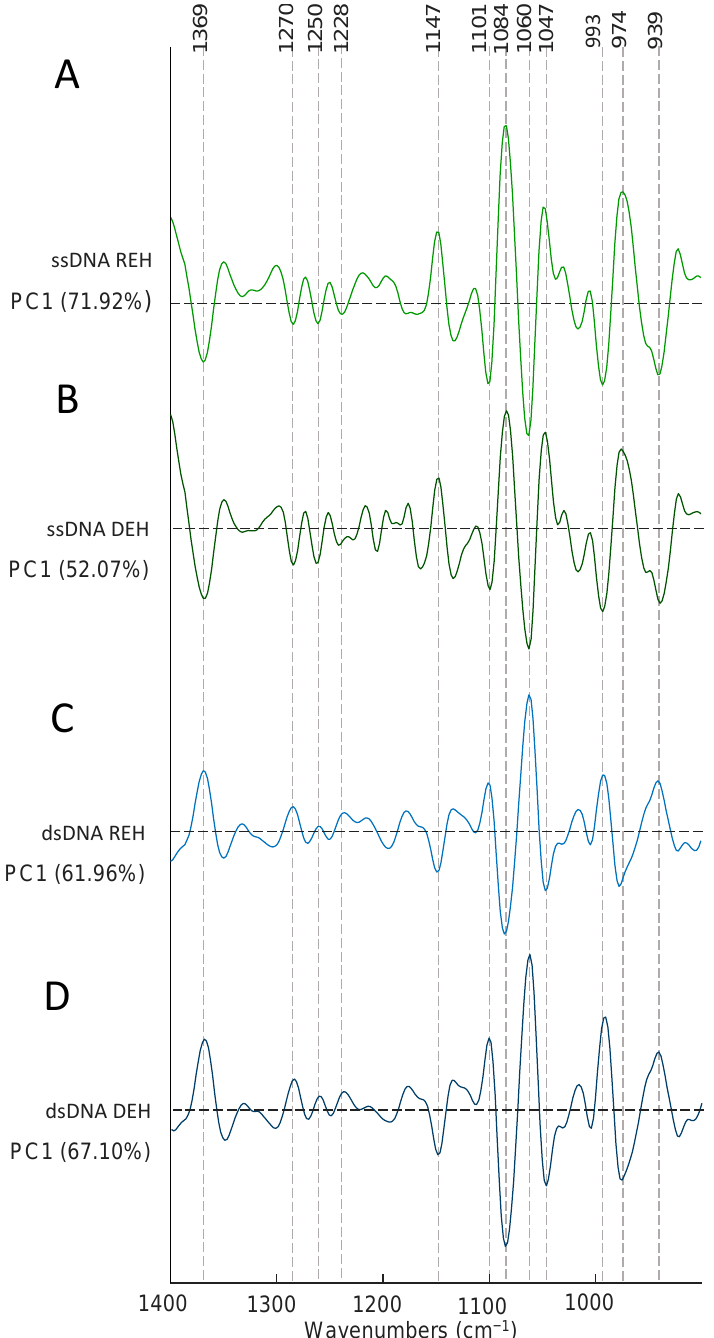
Figure 8. ( A ) PC1 loadings plot depicting ssDNA treated with PFB and TMB and the non-treated DNA (control in acetone/water) in the dehydrated state. The positive loadings are associated with the controls and the negative loadings are associated with the drug inoculated cells; ( B ) PC1 loadings plot for the rehydrated ssDNA with and without drug treatment. The positive loadings are associated with the negative scores. The positive loadings are associated with the controls and the negative loadings are associated with the drug inoculated cells; ( C ) PC1 loadings plot for dehydrated dsDNA with and without drugs. The positive loadings are associated with the drug inoculated cells and the negative loadings are associated with the control cells; ( D ) PC1 versus PC2 loadings plot for rehydrated dsDNA with and without the drugs. The positive loadings are associated with the drug inoculated cells and the negative loadings are associated with the control